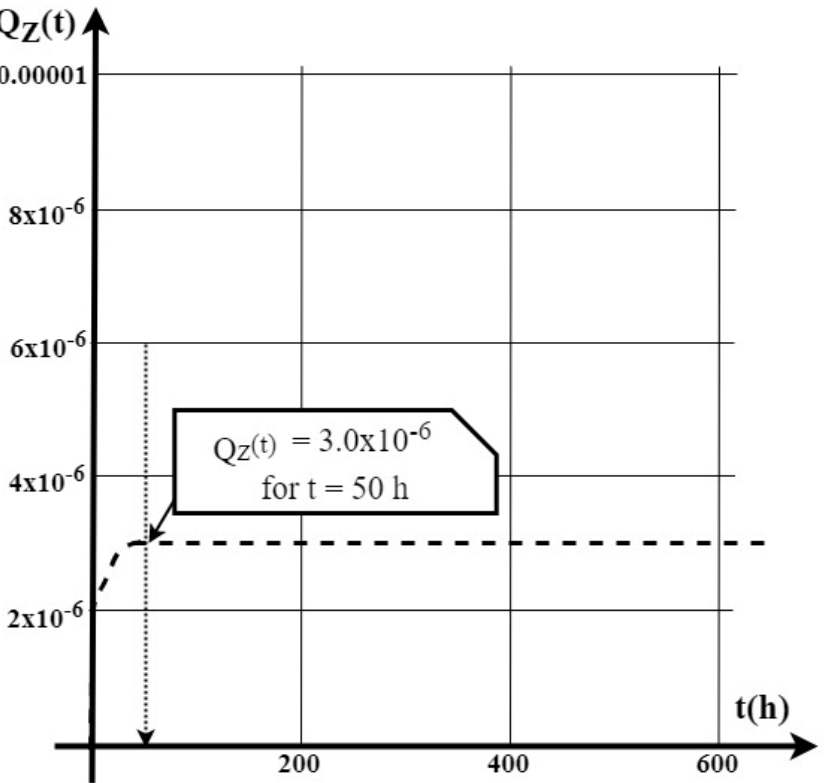
Figure 9. Waveform of the probability function Q Z ( t ) related to an electronic security system staying in a state of safety unreliability. Table 2. Values of the FAS probability function at the initial time of use.